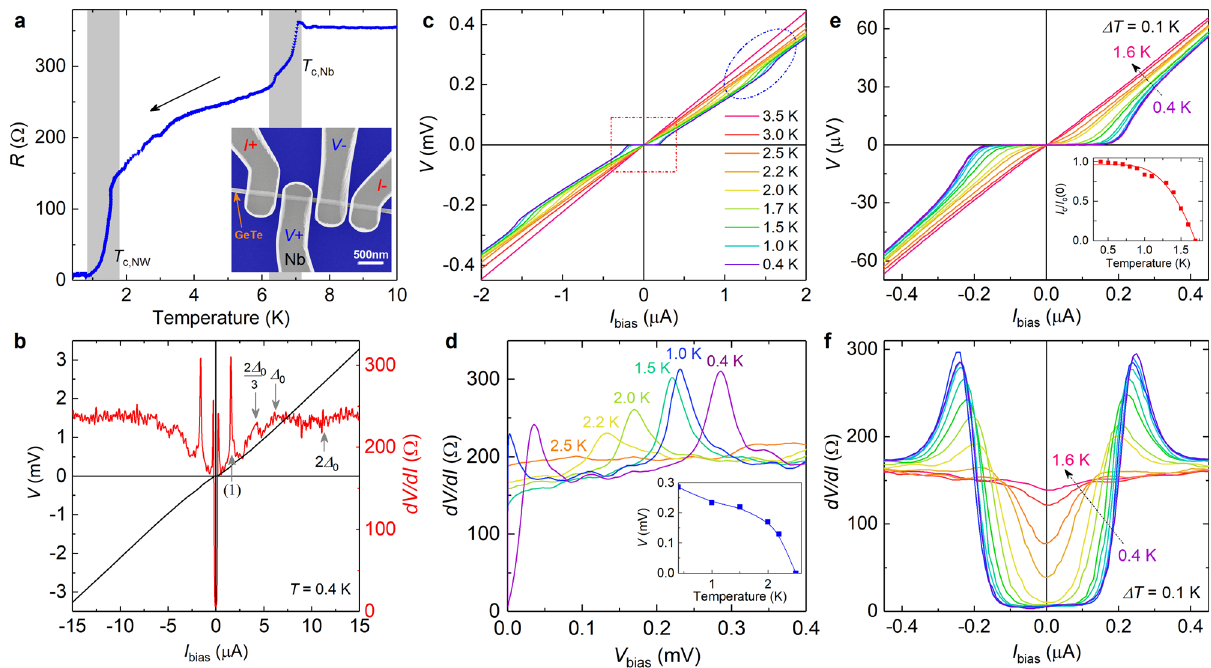
Fig. 3 Transport characteristic of Nb/GeTe-nanowire/Nb junction at zero magnetic fi eld. a Resistance R of a Nb/GeTe-nanowire/Nb junction during a cooling process. There are two transitions ( T c,Nb and T c,NW ) labeled by vertical shadows. Inset: A scanning electron microscopy image of a Nb/GeTe- nanowire/Nb junction. b I – V characteristics and corresponding d V /d I trace of a GeTe-based junction in a high bias current range at 0.4 K. The subgap features at 2 Δ 0 /3 and Δ 0 as well as the location of 2 Δ 0 are indicated by arrows. Furthermore, an additional sharp feature is found at (1). c I – V curves as a function of large bias current range. The superconducting range at small bias currents is indicated by an rectangle and the step feature at around ±1.5 μ A can be found within the ellipse. d Corresponding d V /d I traces as a function of bias voltage at various temperatures. Inset: Position as a function of temperature of the peak assigned feature (1) indicated in b . e I – V characteristics and f the corresponding d V /d I curves in a small bias current range at temperatures between 0.4 and 1.6 K. The inset of e is the experimental (dots) and fi t (solid line) I c / I c (0) as a function of